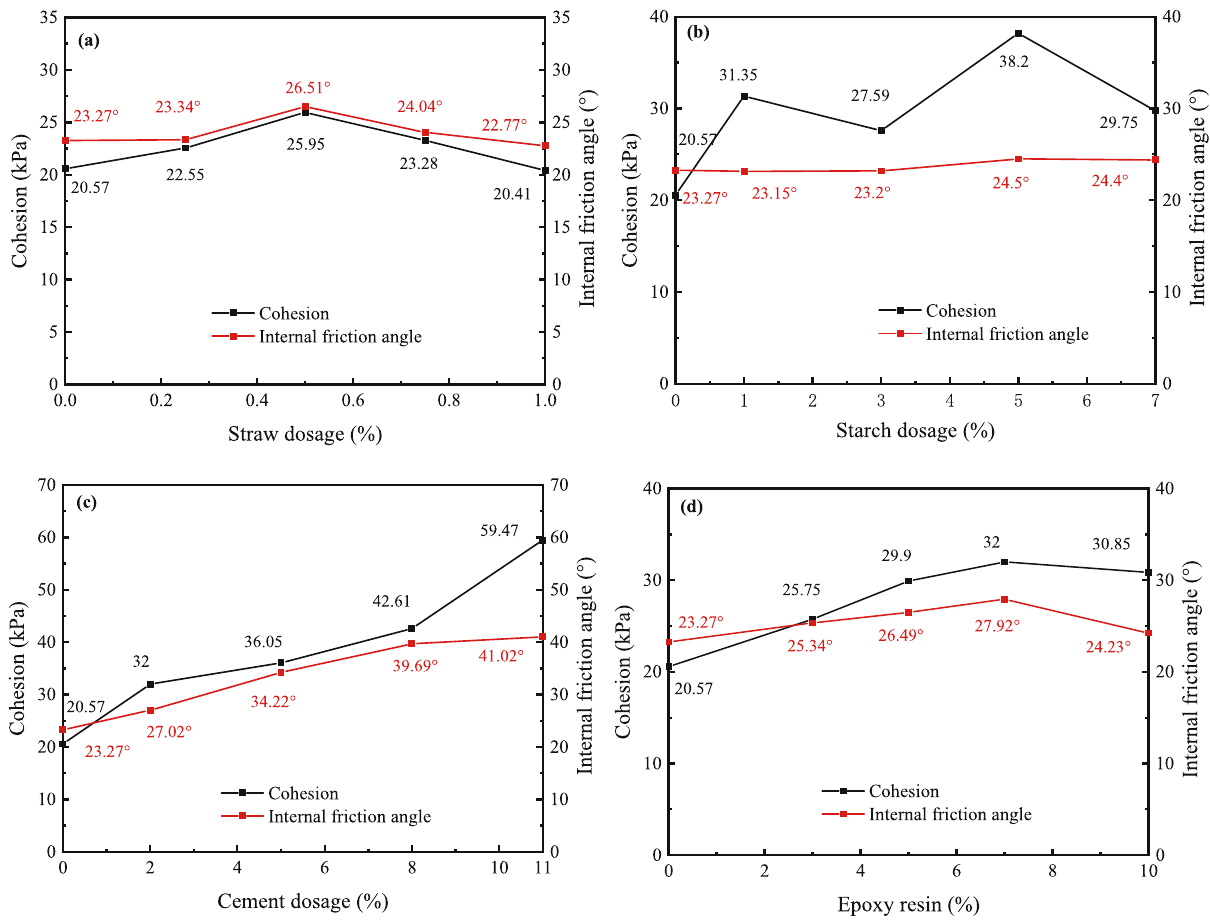
Figure 13: Shear strength indexes of di ff erent materials: ( a ) straw; ( b ) starch; ( c ) cement; and ( d ) epoxy